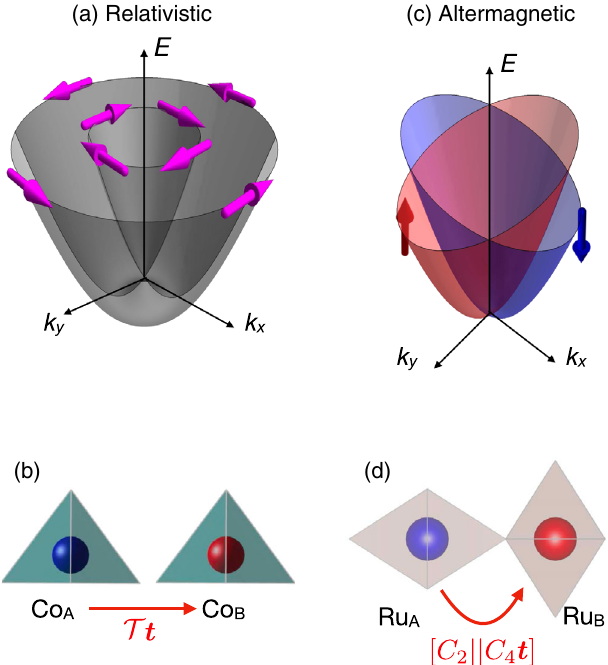
FIG. 9. (a) Model relativistic Rashba spin-split bands. (b) Model of antiferromagnetic zero-magnetization crystal of BiCoO 3 with magnetic symmetry T t , and with broken space-inversion symmetry. (c) Model nonrelativistic altermagnetic spin split- ting. (d) Model of altermagnetic crystal of RuO 2 with non- relativistic spin symmetry ½ C 2 k C 4 t (cid:2) . The crystal are discussed in Refs.